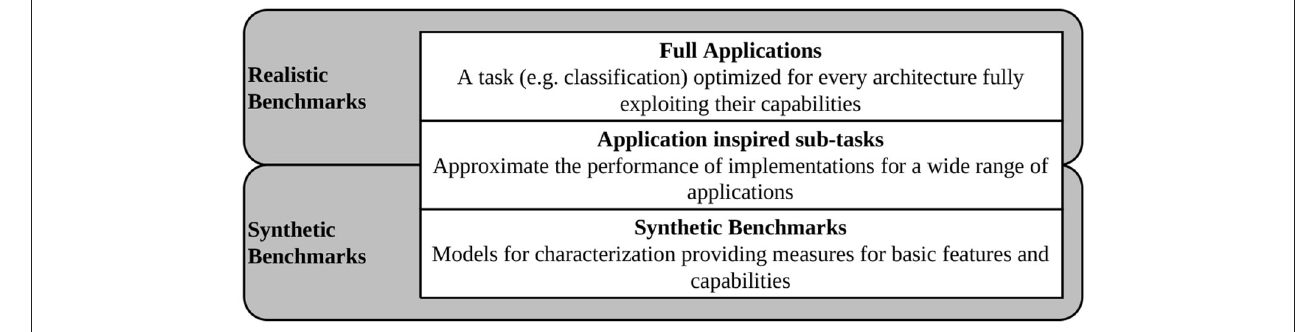
FIGURE 2 | Different categories of benchmarks implemented in